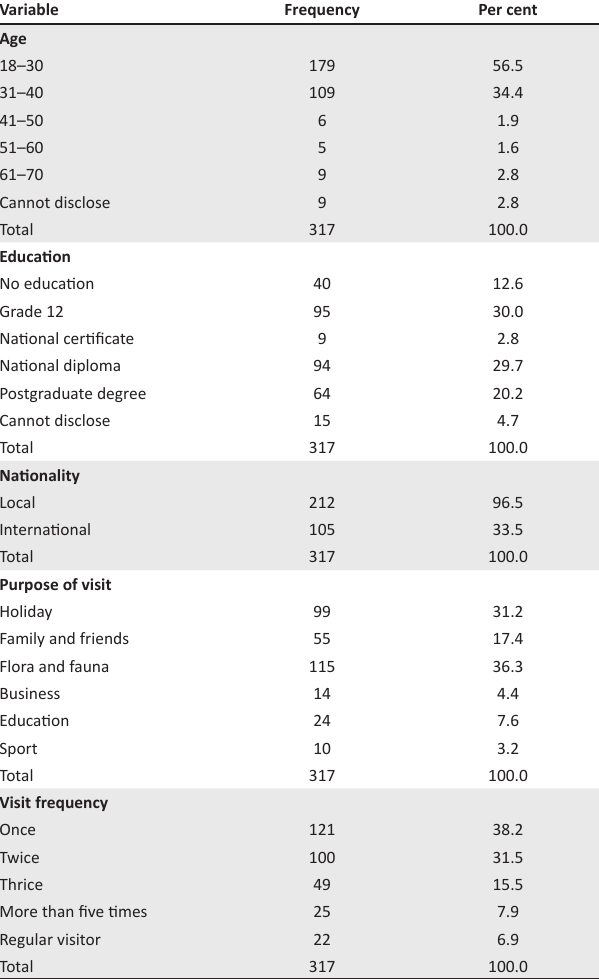
TABLE 1: Analysis of demographic data of the respondents. Variable Frequency Per